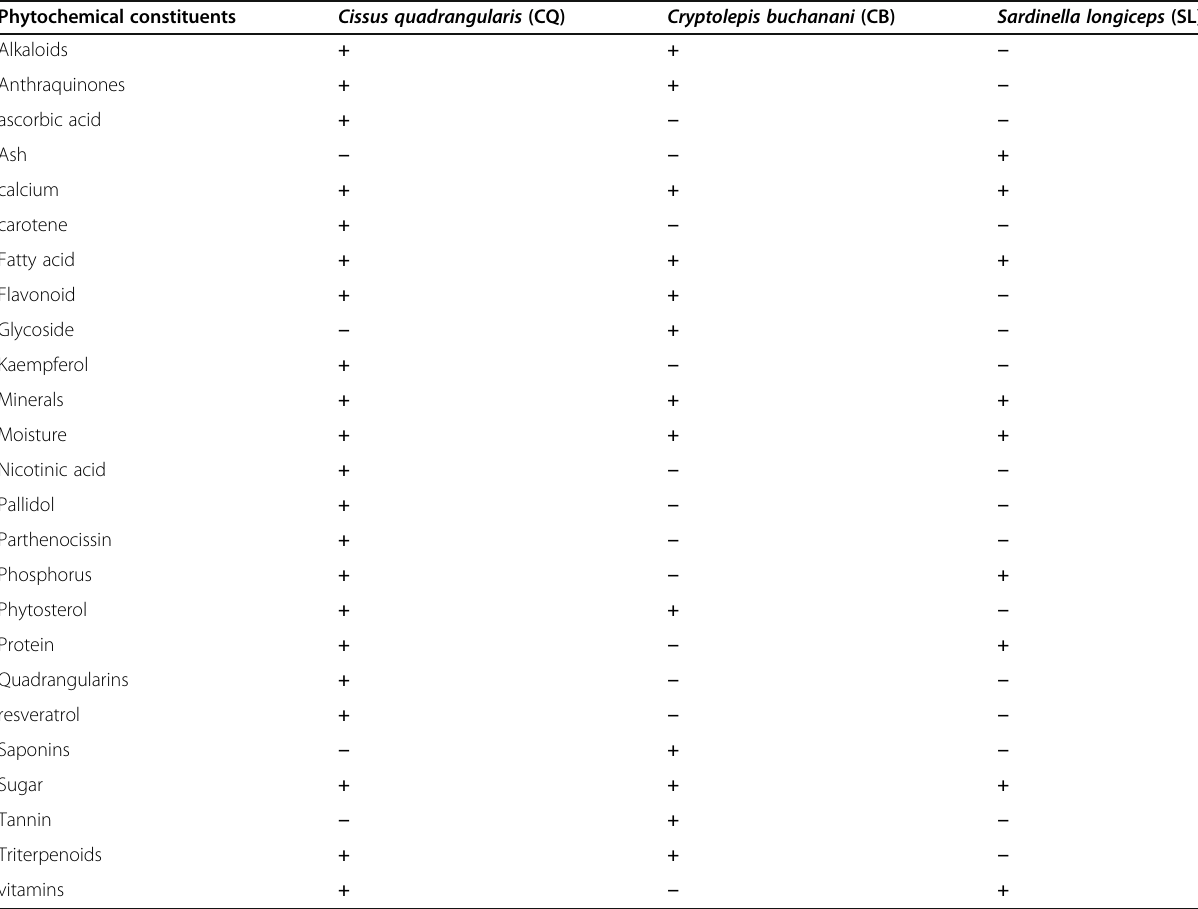
Table 2 Phytochemical Constituents of natural compounds Phytochemical